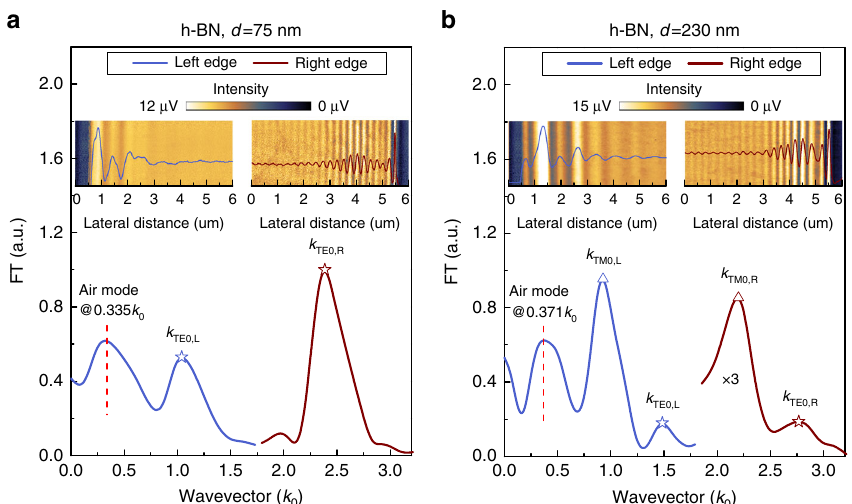
Fig. 4 Probing optical anisotropy of h-BN in the visible region. Experimental results for a 75-nm-thick and b 230-nm-thick h-BN samples. In a , the h-BN nano fl ake was placed in the same orientation as in Fig. 1a; in b , the two opposite edges are not exactly parallel and there are small angles between the edges and the direction of the s-SNOM tip cantilever as shown in Supplementary Fig. 9b. There is a small frequency difference between the air modes in a and b because of the different β angles shown in Supplementary Fig. 9. Note that in b the spectrum taken at the right edge is multiplied by